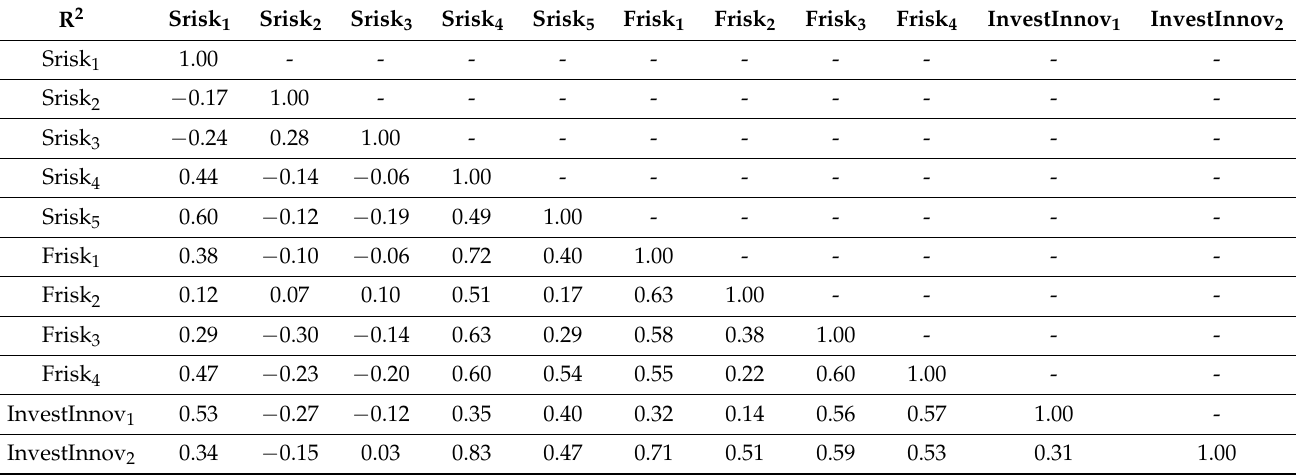
Table 5. The matrix of cross correlation of the